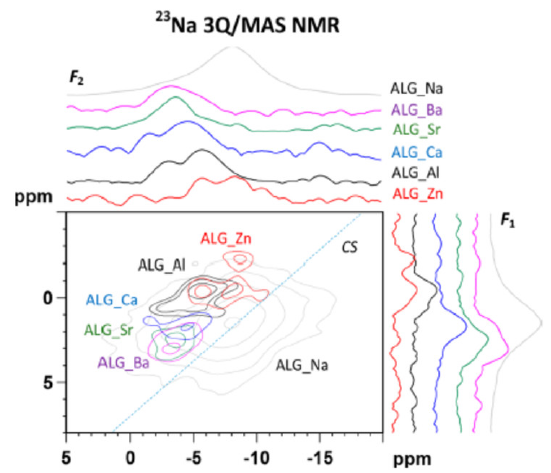
Figure 10. 2D 23 Na 3Q/MAS NMR spectra of mono- (Na + ) and multivalent ions alginate gels. Reprinted with permission from [216] (Available online: https://pubs.acs.org/doi/full/10.1021/acs.biomac.7b00627. Accessed on 14 November 2022. Further permission related to the material excerpted should be directed to the ACS.).